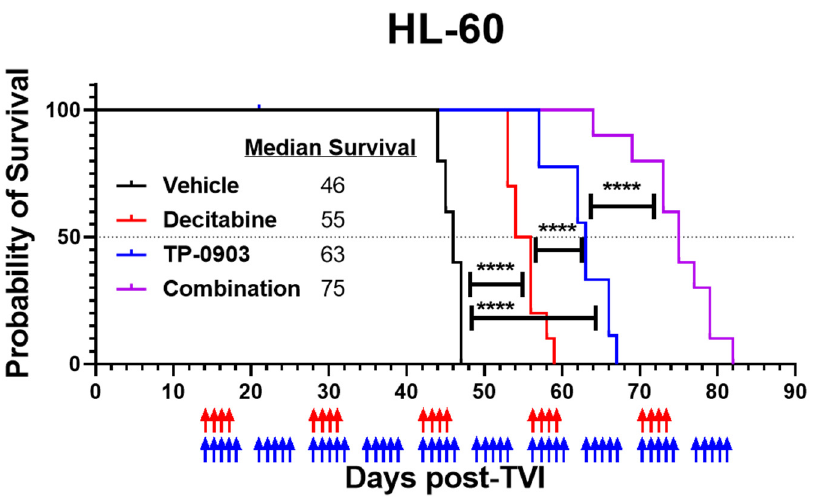
Figure 5. TP-0903 is active in an HL-60 xenograft model. Kaplan–Meier survival curve of NCG mice after intravenous injection with HL-60 cells (10 per treatment cohort). Fourteen days after TVI, mice were treated with vehicle, TP-0903 (50 mg/kg orally; 5 days on/2 days off), decitabine (0.4 mg/kg i.p.; 4 days on/10 days off), or the combination. Blue and red arrows represent days of TP-0903 and decitabine treatment, respectively. The TP-0903/decitabine combination prolonged median survival (75 days) compared to cohorts of mice treated with TP-0903 (63 days), decitabine (55 days), or vehicle (46 days) (**** p < 0.0001).